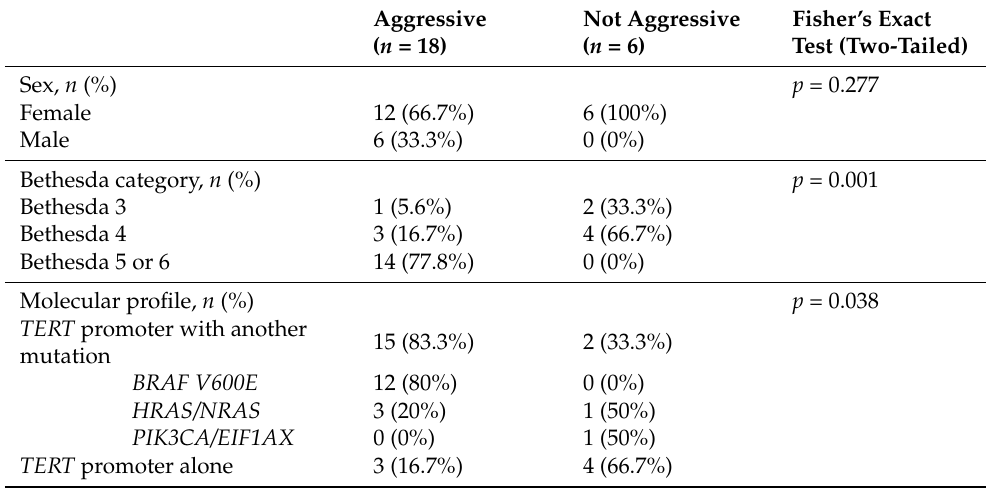
Table 2. Association between disease aggressiveness, sex, Bethesda category, and molecular profile. Aggressive ( n =